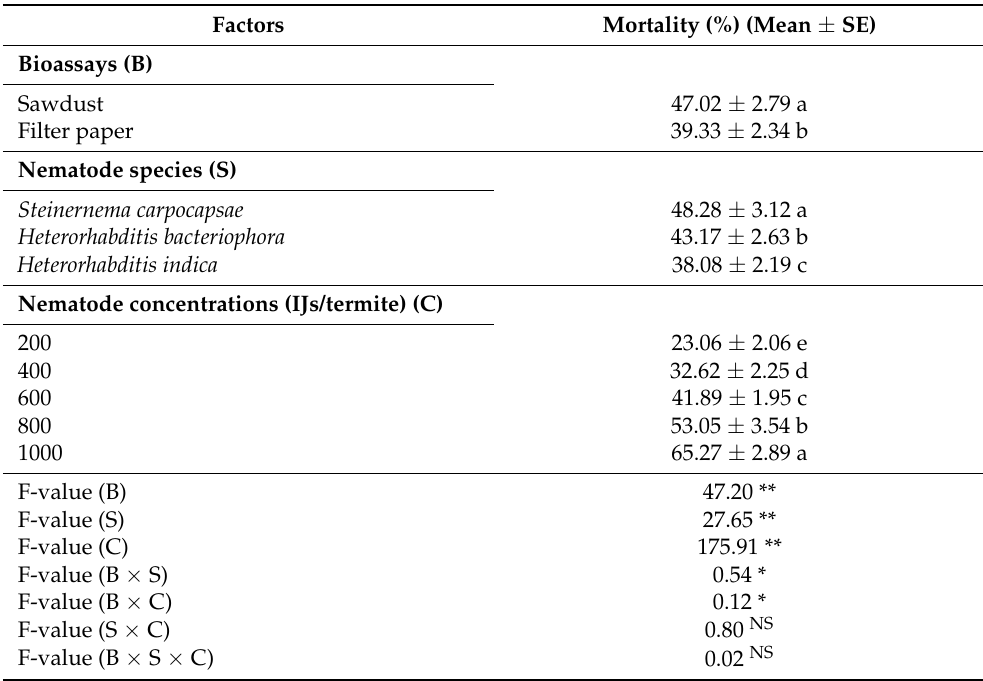
Table 1. Effect of bioassay methods (B), nematode species (S) and their concentrations (C) on mortality (%) of Odontotermes obesus workers kept under laboratory conditions at 16 ± 1 ◦ C.